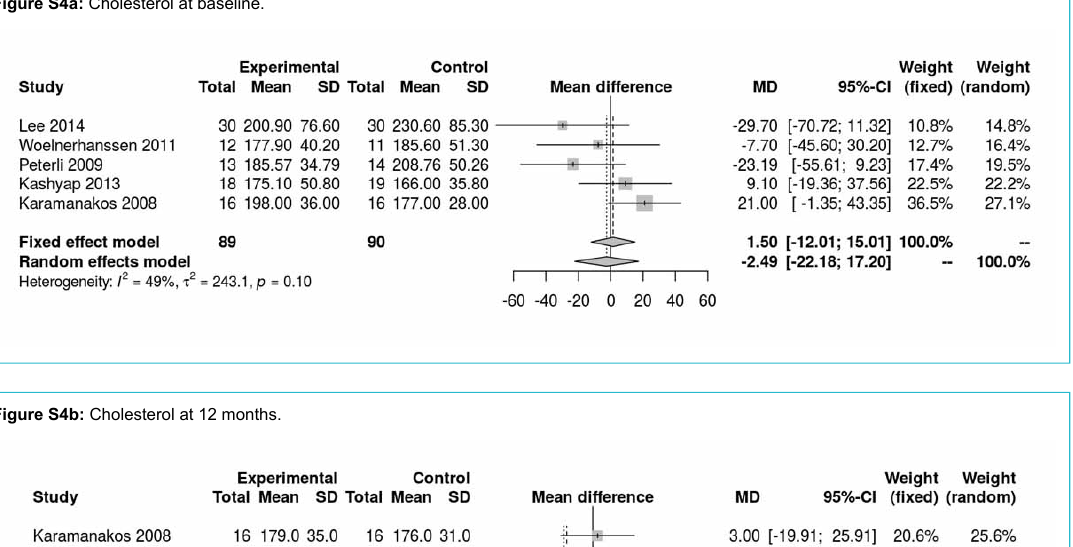
Figure S4a: Cholesterol at baseline.